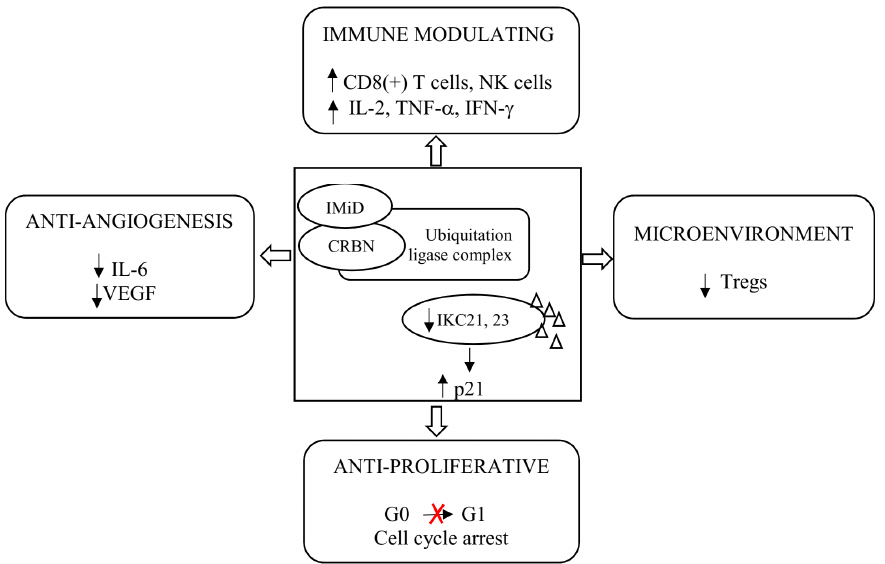
Figure 2. Mechanism of action of immunomodulatory drugs. Abbreviations: CRBN: Cereblon; IFN- γ : Interferon γ ; IL: Interleukin; IMiD: Immunomodulatory drug; NK: Natural killer; Tregs: Regula- tory T cells; TNF- α : Tumor Necrosis Factor α ; and VEGF: Vascular Endothelial Growth Factor.